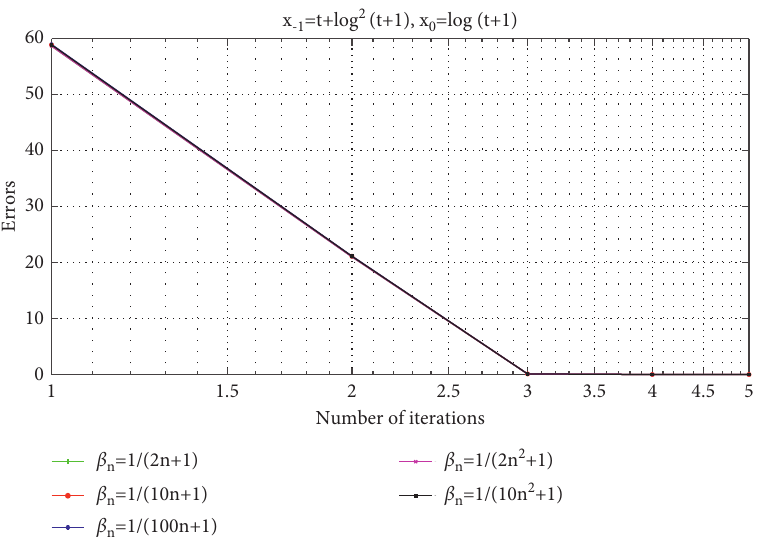
Figure 12: The Cauchy error plotting number of iterations for different parameters β